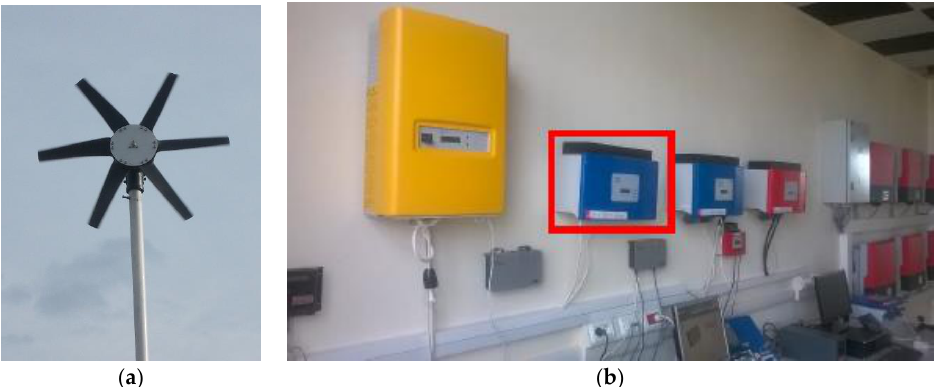
Figure 8. The components of Subsystem 3: ( a ) the wind system; and ( b ) the Windy Boy WB1100LV inverter.